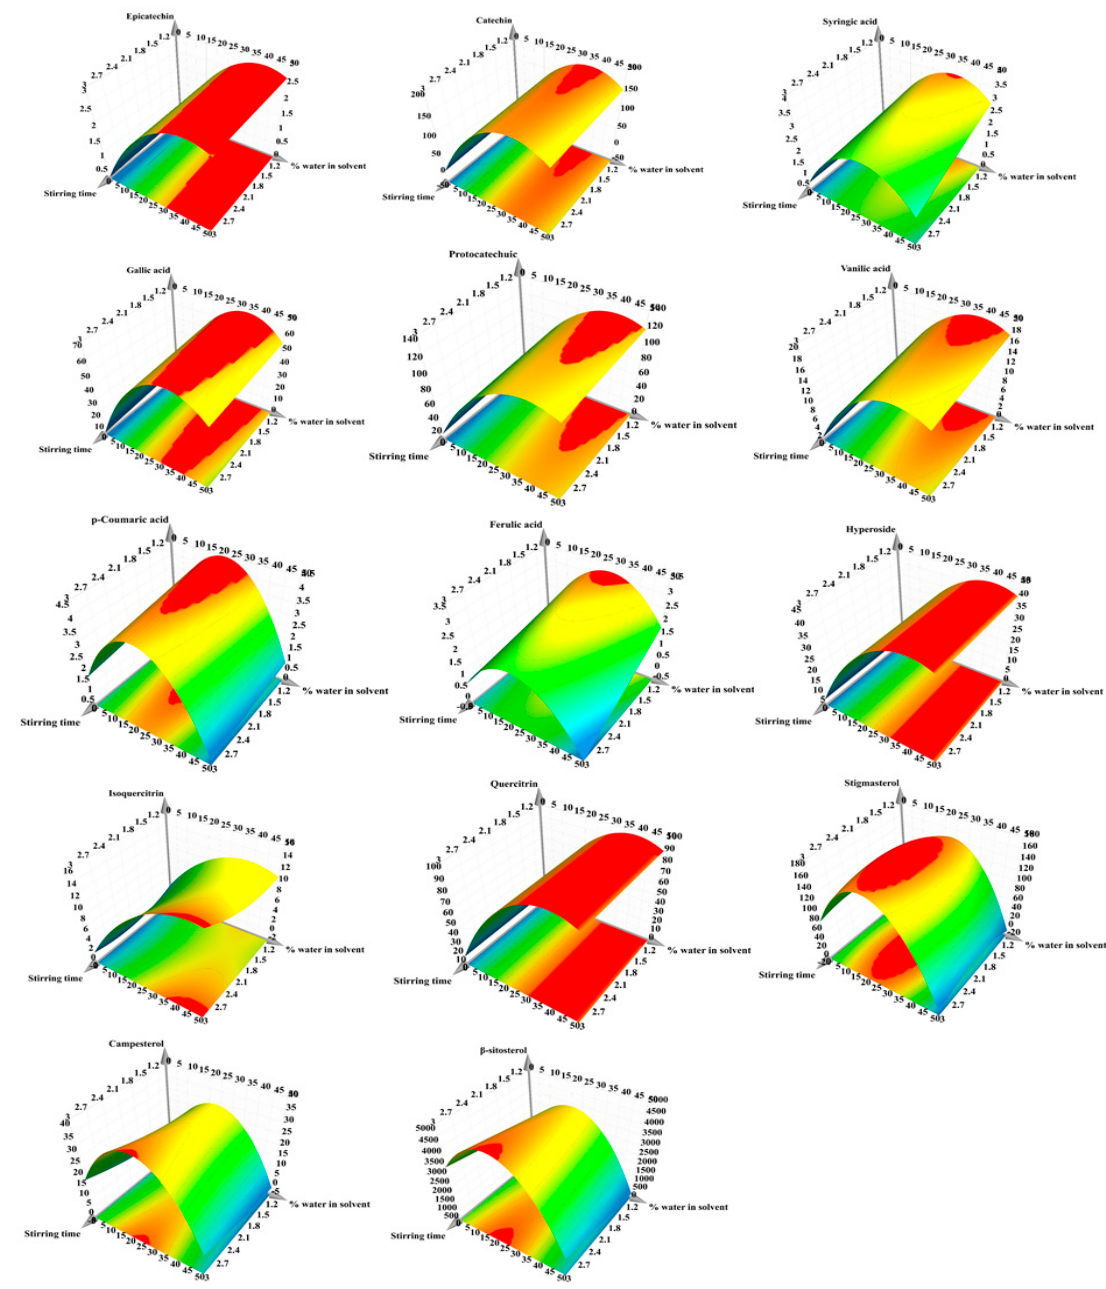
Figure 4. Response surface for prediction of bioactive compound recovery from hazelnut involucre extracts with respect to: X 1 , stirring time (min); X 2 , pH; X 3 , water in solvent (% v / v ). The regions in red represent the domains of working conditions assuring the maximum extraction yield for the evaluated bioactive compounds.